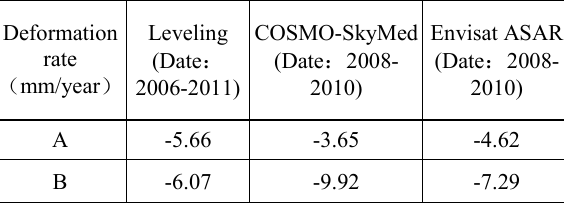
Table1. Comparing the average displacement rate in vertical